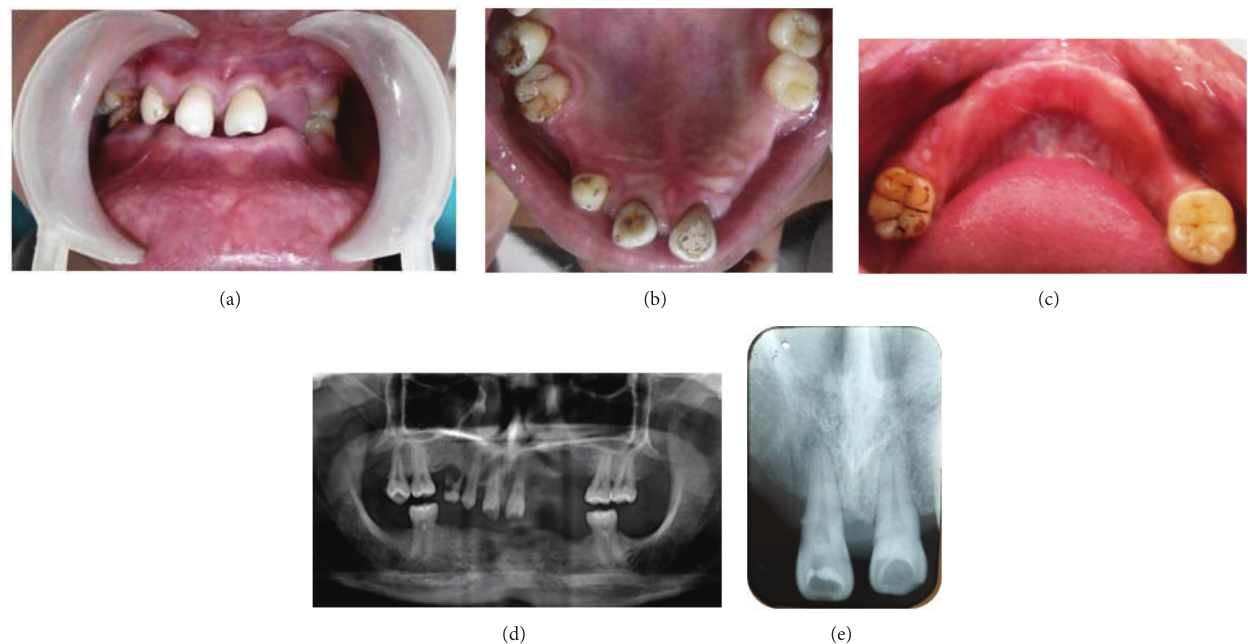
Figure 1: (a) Intraoral photograph of Sibling 1. (b) Intraoral photograph of maxillary arch of Sibling 1. (c) Intraoral photograph of mandibular arch of Sibling 1. (d) OPG of Sibling 1. (e) IOPA of Sibling 1 showing dens invaginatus in both the central incisors.